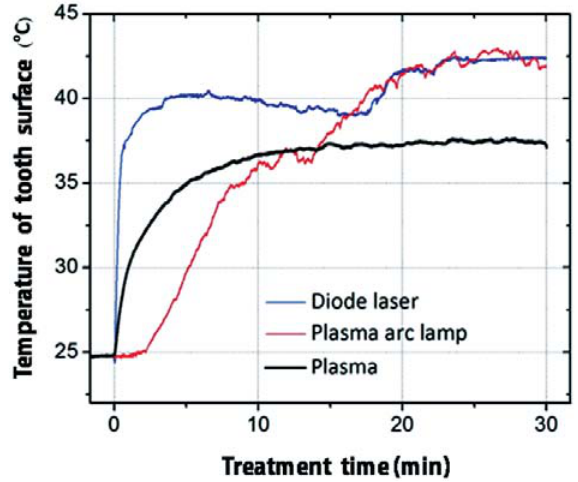
Figure 4- The temperature measurement during tooth bleaching using different light sources. During treatment with light sources, the temperature was measured at